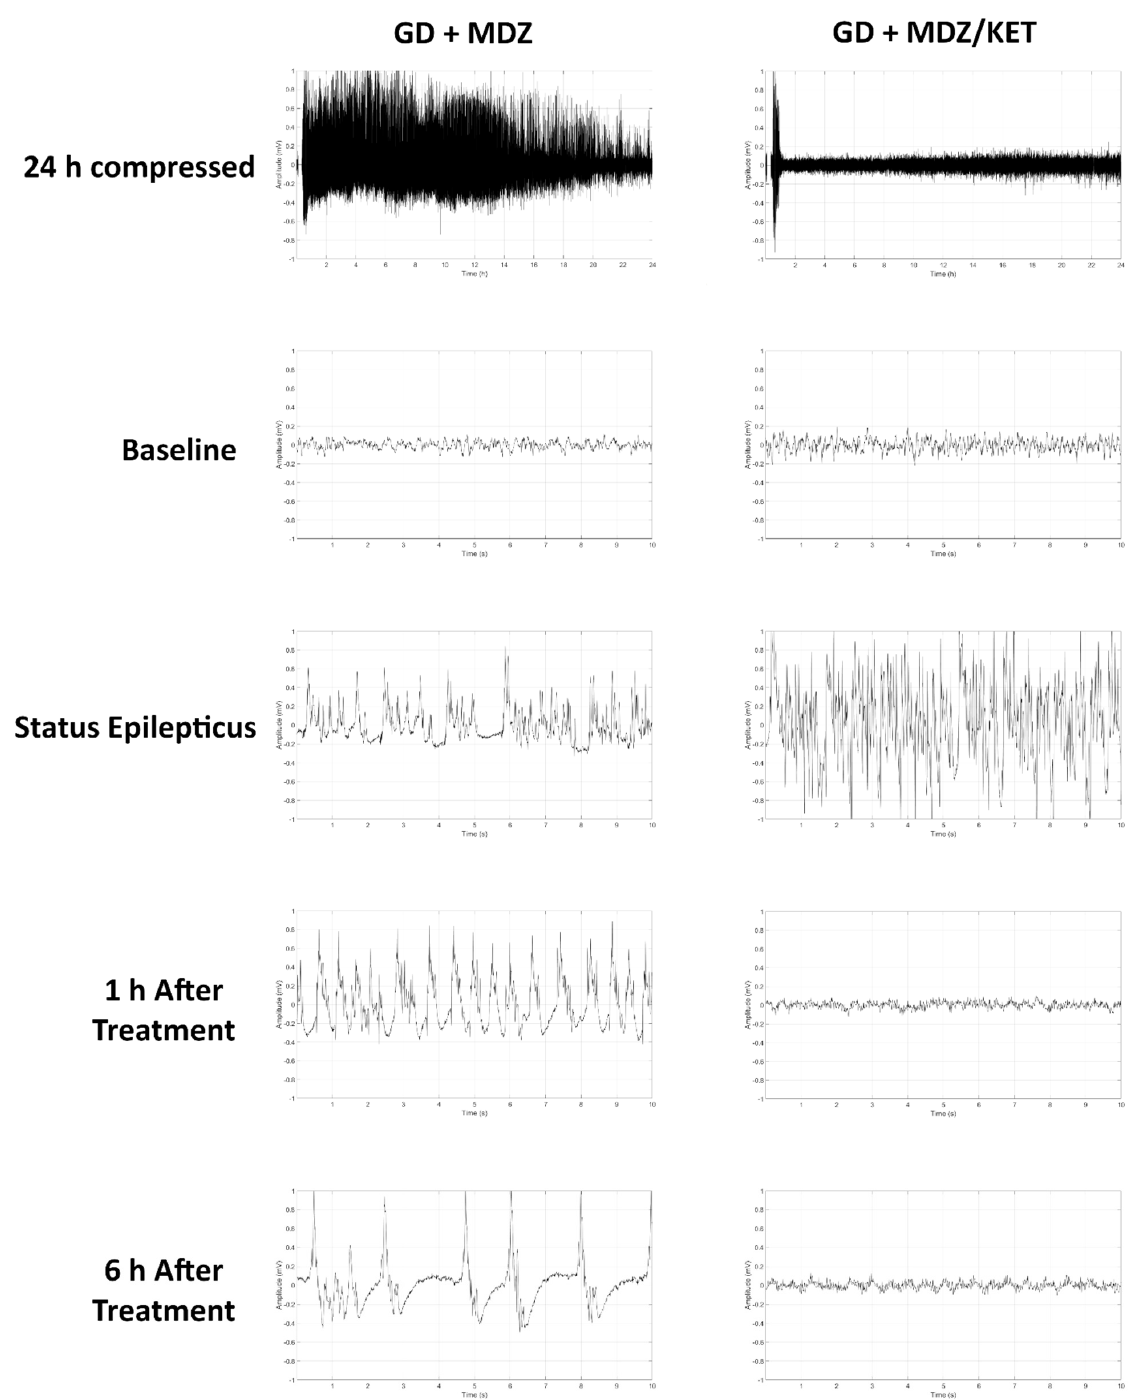
Figure 6. Effects of ketamine as an adjunct to delayed midazolam treatment on soman-induced EEG activity in KIKO mice. Representative images are shown of 24 h compressed signal and 10-sec recordings at baseline (24 h prior to soman exposure), status epilepticus, 1 h after midazolam treatment, and 6 h after midazolam monotherapy (GD+MDZ) or midazolam/ketamine (GD + MDZ/KET) combination therapy.